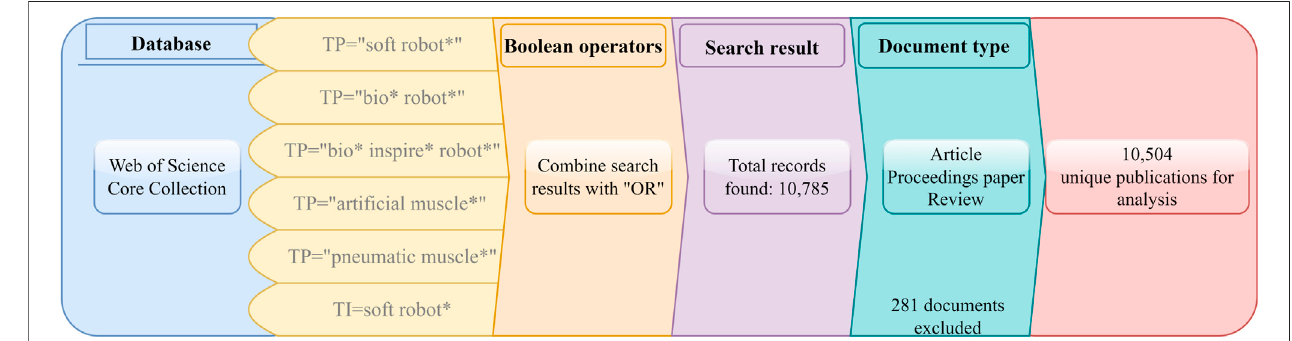
FIGURE 1 | The fl owchart that reports the publication selection procedure (TP, topic; TI, title).